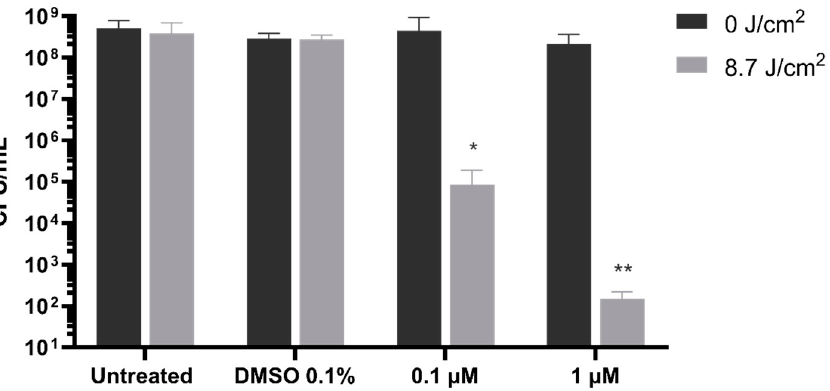
Figure 4. Photodynamic inactivation of Staphylococcus aureus by 0.1 and 1 µ M of BODIPY dissolved in DMSO. Irradiation with light at 520 nm was performed for 1 h to reach a final dose of 8.7 J/cm 2 . Untreated and DMSO (0.1% V / V )-treated samples were included as controls. Data of cell viability are expressed as CFU/mL ± standard deviations. Statistical analyses were performed by one-way ANOVA (* p < 0.05; ** p < 0.01).